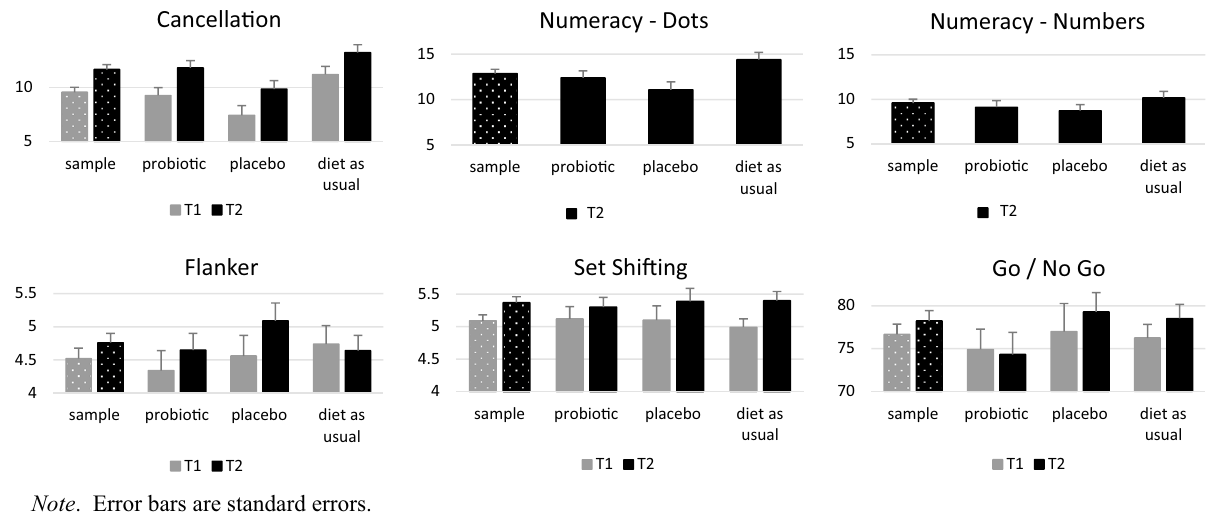
Figure 2. Mean cognitive test scores at T1 and T2 by group. Error bars are standard